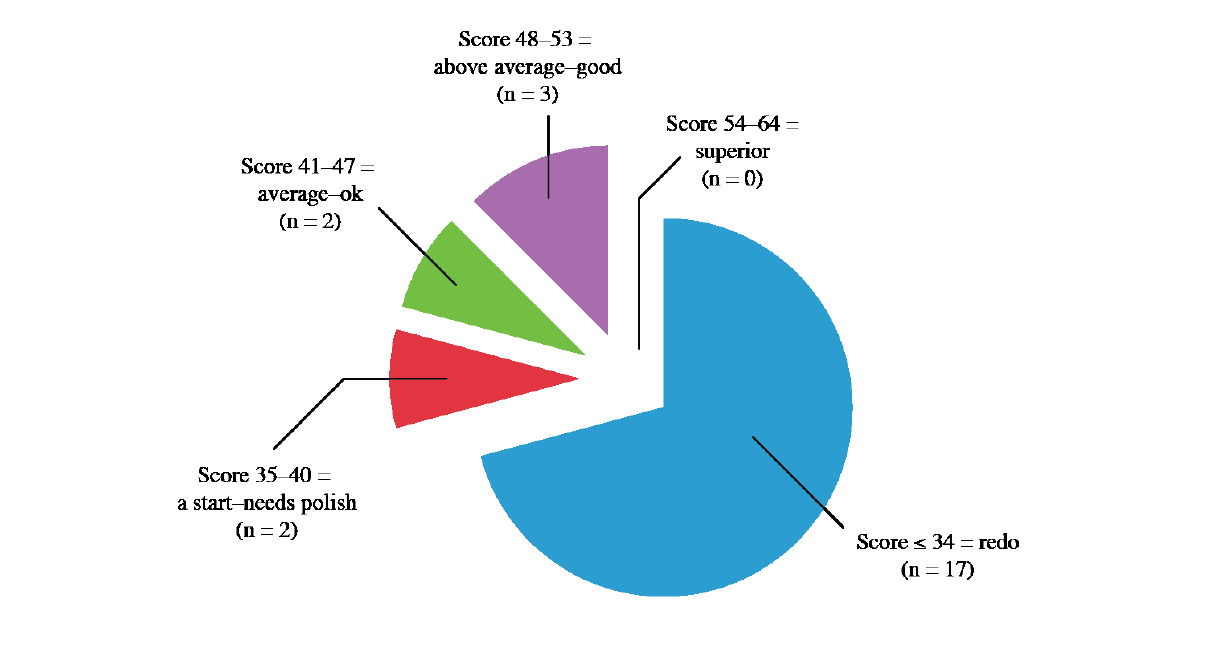
Figure 1. Distribution of courses evaluated by course quality without suggested changes.